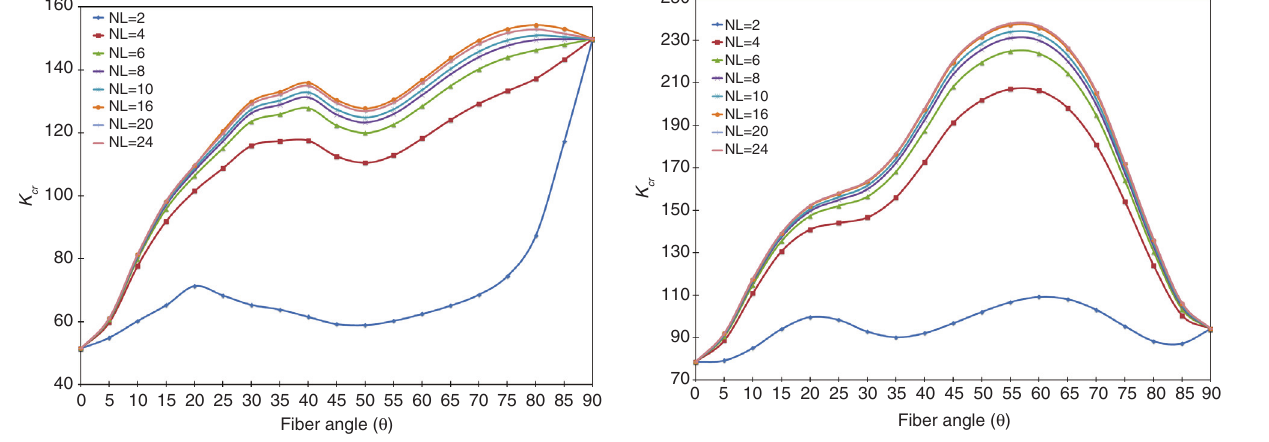
Figure 11 Critical buckling load parameter for clamped antisymmet- ric cylindrical skew panel (Ø = 15 ° , α = 0 ° ).